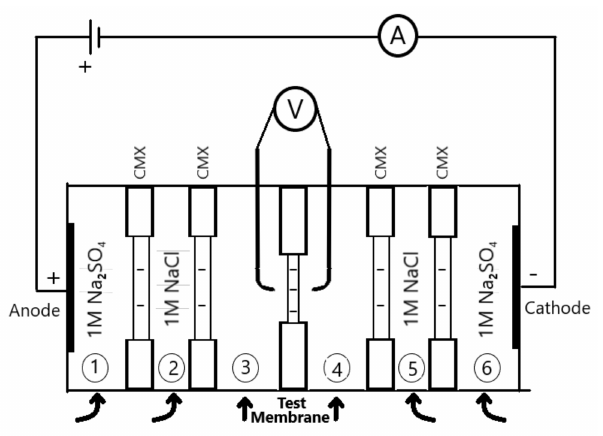
Figure 2. Scheme of the six-compartment resistance characterization cell.